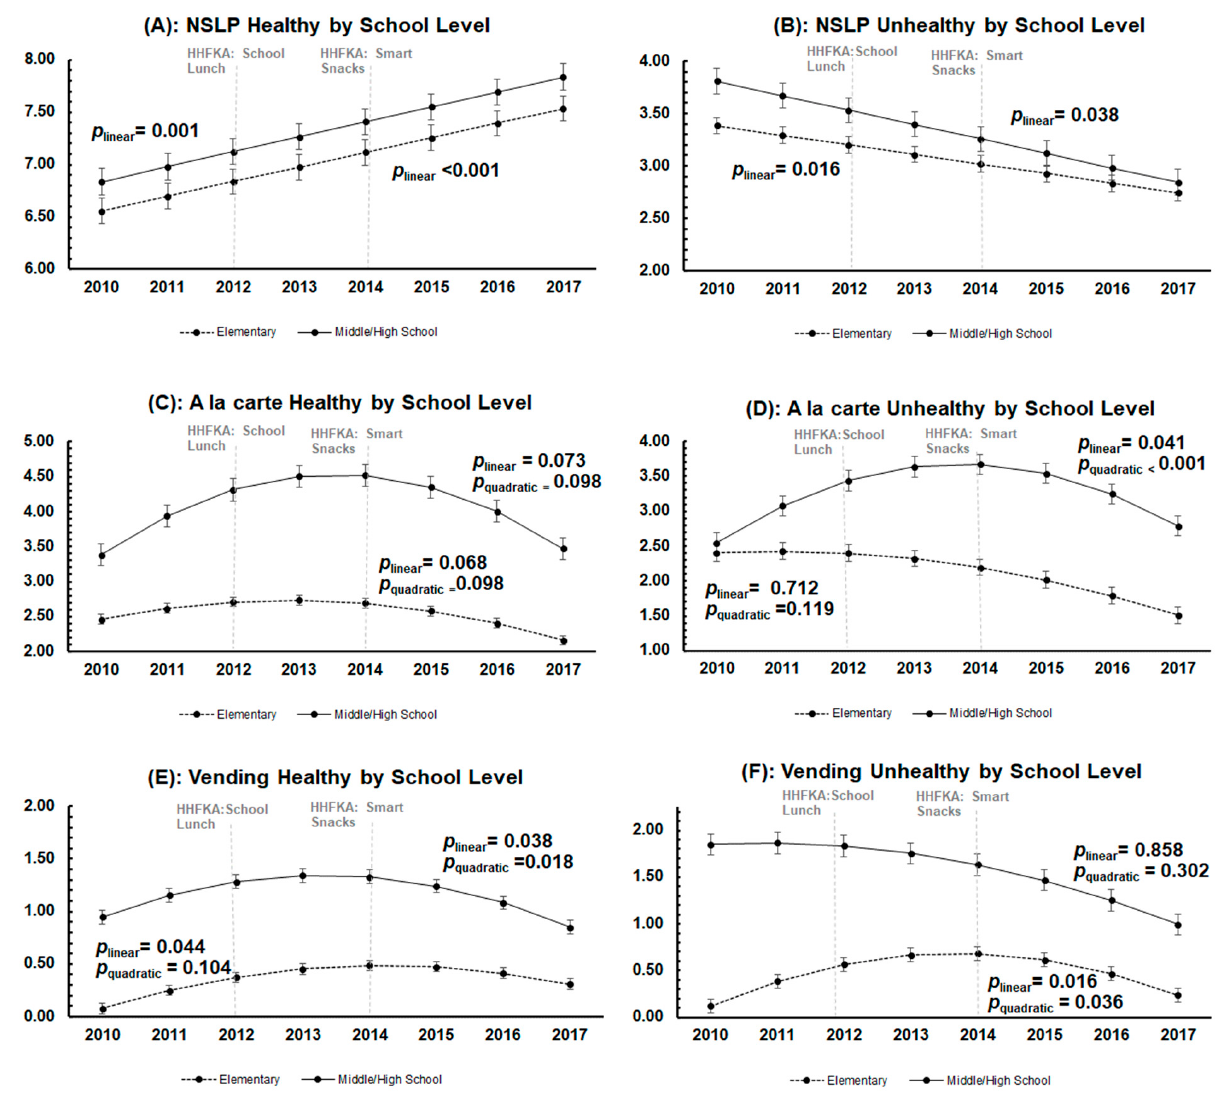
Figure 4. Year-by-year point estimates and predicted trends of each of the six food environment indices from school year 2010-11 to 2017-18 by school level. Dots represent the adjusted point estimates with confidence intervals estimated from the multilevel multivariable linear regression model. Lines represent the predicted line of best fit over the study period. The 2012 vertical line represents the implementation of the Healthy Hunger-Free Kids Act (HHFKA) guidelines for NSLP that occurred in 2012. The 2014 vertical line represents the implementation of the Smart Snacks guidelines (within the HHFKA) that occurred in 2014.